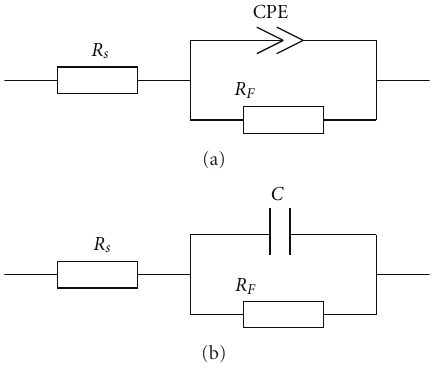
Figure 5: Equivalent circuits: (a) ZARC and (b) the Ershler-Randles circuit. CPE is the constant phase element, C is the di ff erential capacitance, R F is the charge-transfer resistance, and R s is the series